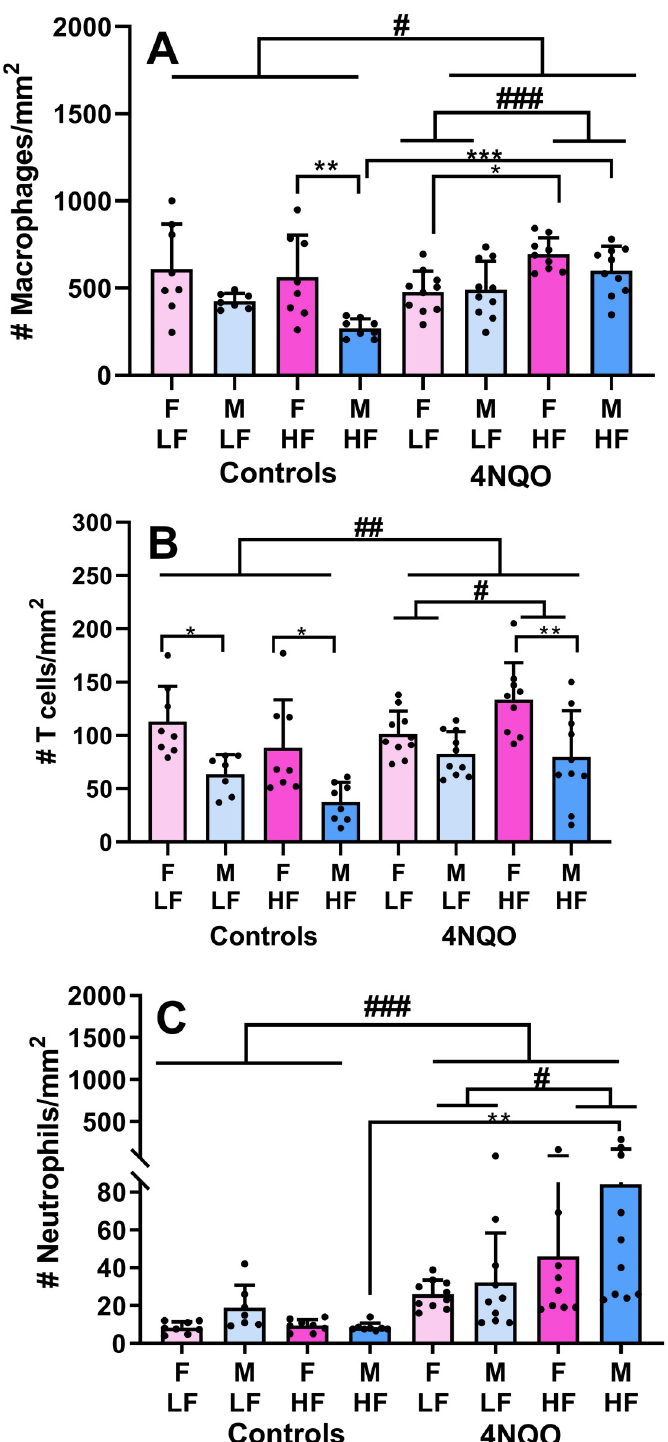
Fig 5. Hepatic lymphoid cell counts from each treatment group. (A) CD68 + macrophages per mm 2 . (B) CD3+ T cells per mm 2 . (C) Ly6+ neutrophils per mm 2 . Data shown are mean values ± SD. # refers to the 3-way ANOVA. � refers to results from the Bonferroni post-hoc test for multiple